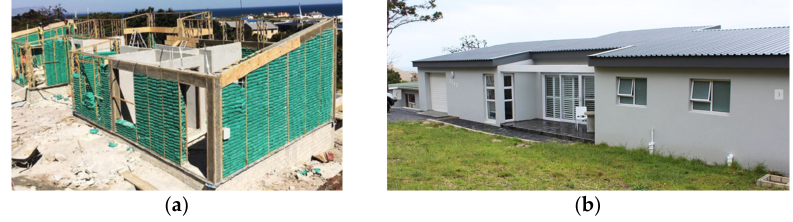
Figure 1. ( a ) SBT house under construction; ( b ) SBT house post ‐ construction.